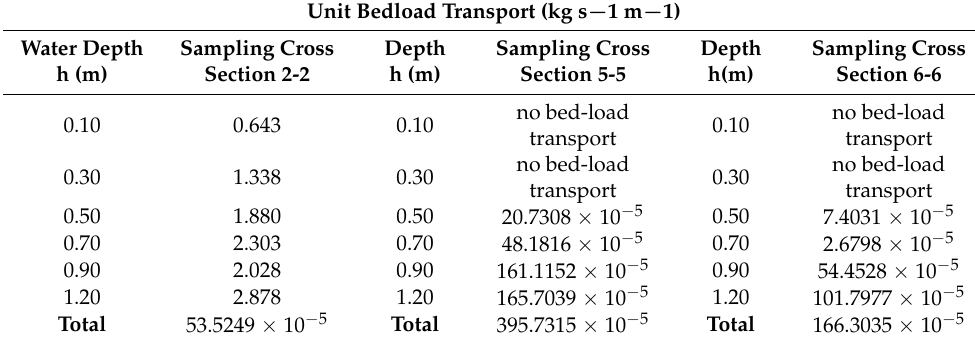
Table 4. Unit bed-load transport measured in sampling cross sections: 2-2 ‘check-dam reservoir’; 5-5 ‘school’ and 6-6